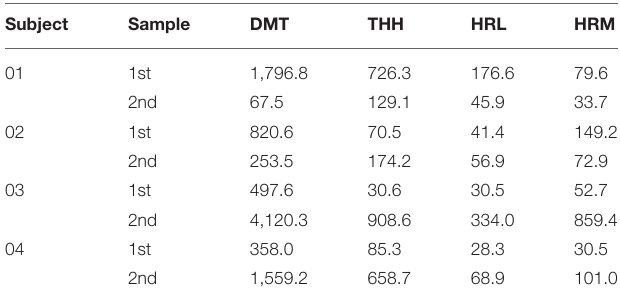
TABLE 7 | Concentrations (ng/ml) of ayahuasca alkaloids in authentic samples after quantification by HF-LPME and